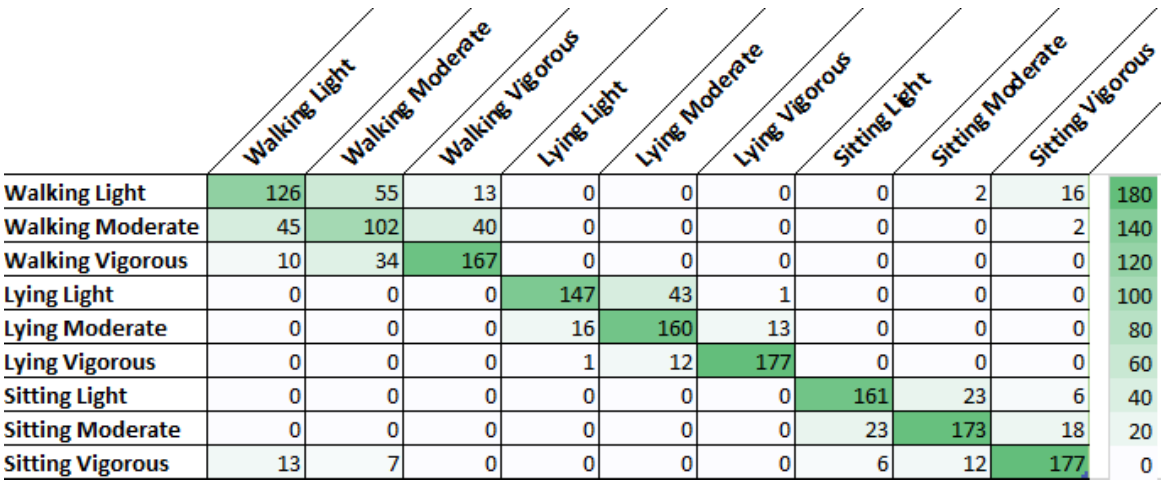
Figure 4. Confusion matrix for classification with Random Forest